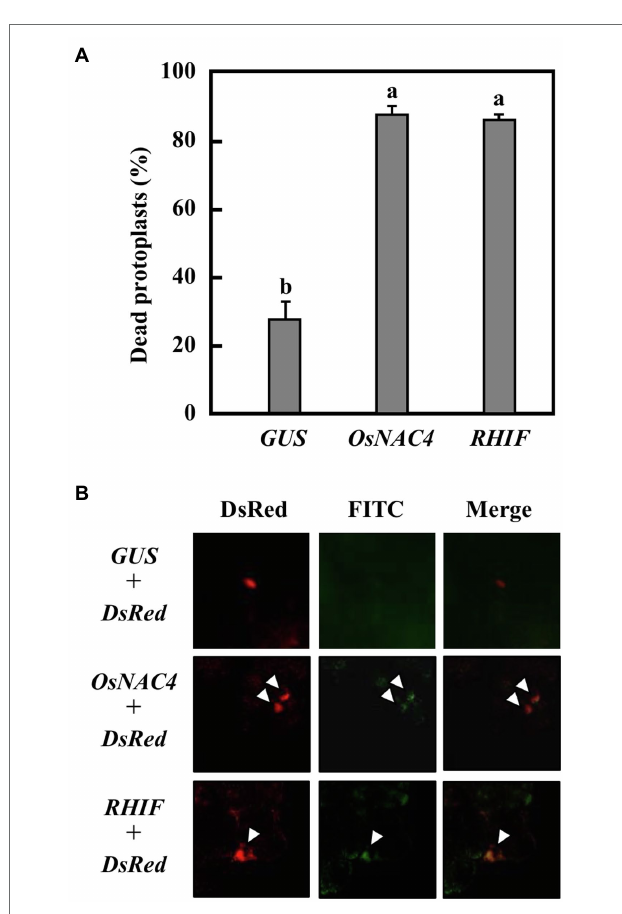
FIGURE 4 | HR cell death induction by RHIF . (A) Percentage of dead protoplasts induced by expression GUS , OsNAC4 , and RHIF. HR cell death was detected by Evans blue staining. Error bars represent standard deviation of three independent experiments. Values followed by a different letter were significantly different according to Tukey-Kramer test ( p < 0.05). (B) DNA fragmentation detected by TUNEL staining. GUS and DsRed (upper panels), NRHIF and DsRed (middle panels), and KRHIF and DsRed (lower panels) were co-expressed. The arrow indicates the TUNEL-positive nucleus.